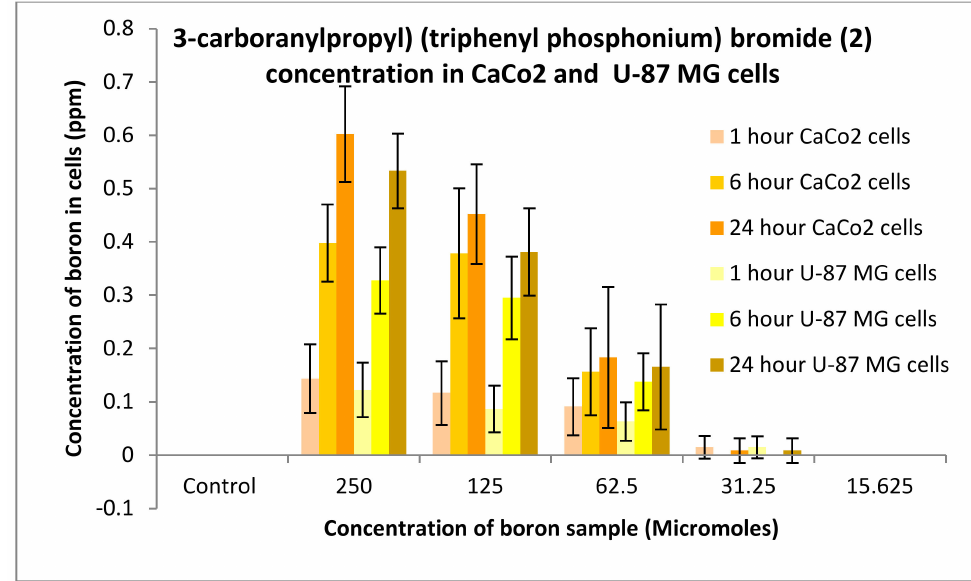
Figure 16. Uptake of boron for 3-carboranylpropyl) (triphenyl phosphonium) bromide (2) into CaCo2 and U87 MG cells after 1, 6 and 24 h.